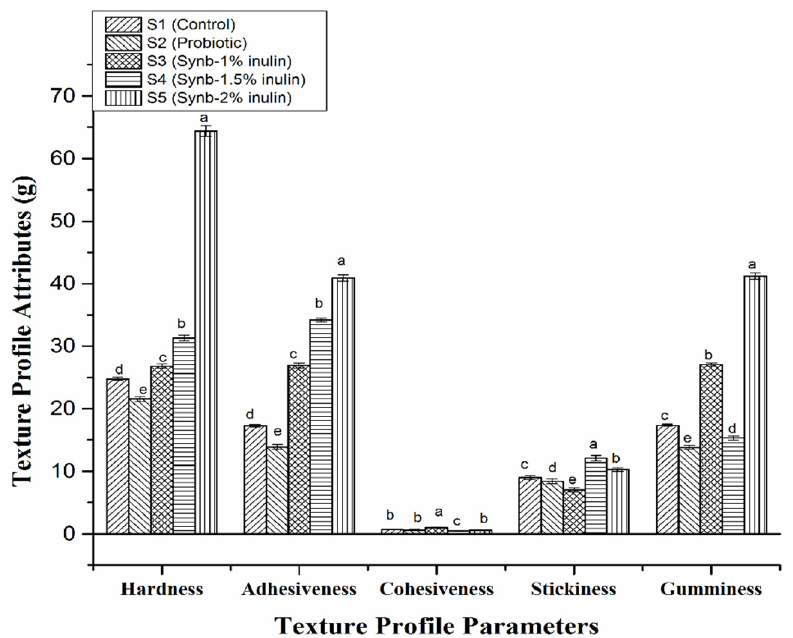
Figure 2. Texture profile analysis of the control plain yogurt (S1), probiotic yogurt with 0.5% S. boulardii (S2), synbiotic yogurt with 0.5% S. boulardii + 1% inulin (S3), 0.5% S. boulardii + 1.5% inulin (S4), and 0.5% S. boulardii + 2% inulin (S5). Di ff erent letters denote statistical di ff erences ( p <